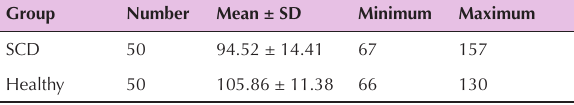
Table 1. The mean and standard deviation of IQ scores of the samples